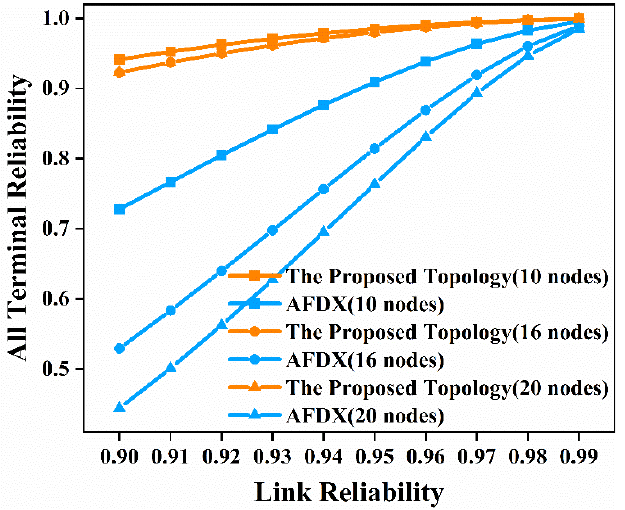
Figure 11. Time ‐ independent, all ‐ terminal reliability comparison diagram of the proposed topology Figure 11. Time-independent, all-terminal reliability comparison diagram of the proposed topology and AFDX in the three scenarios. and AFDX in the three